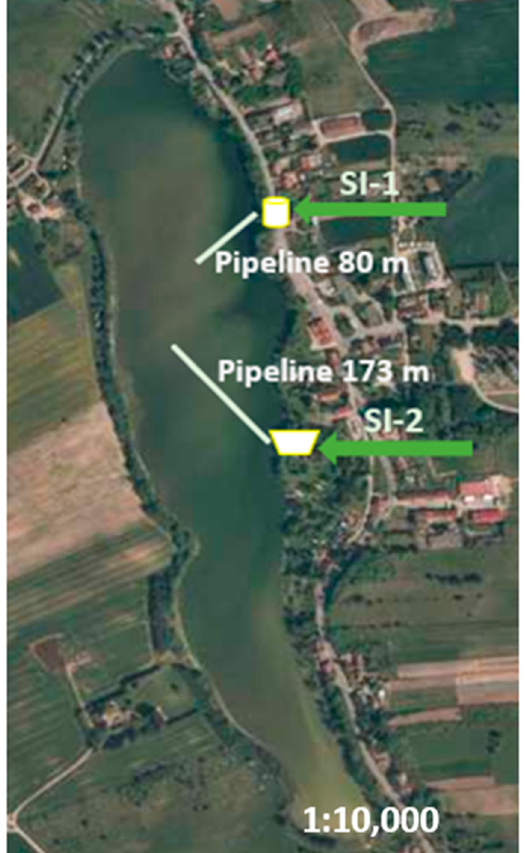
Figure 9. Scheme of siting of the pipelines for the oxygenation of Mi ł kowskie Lake.